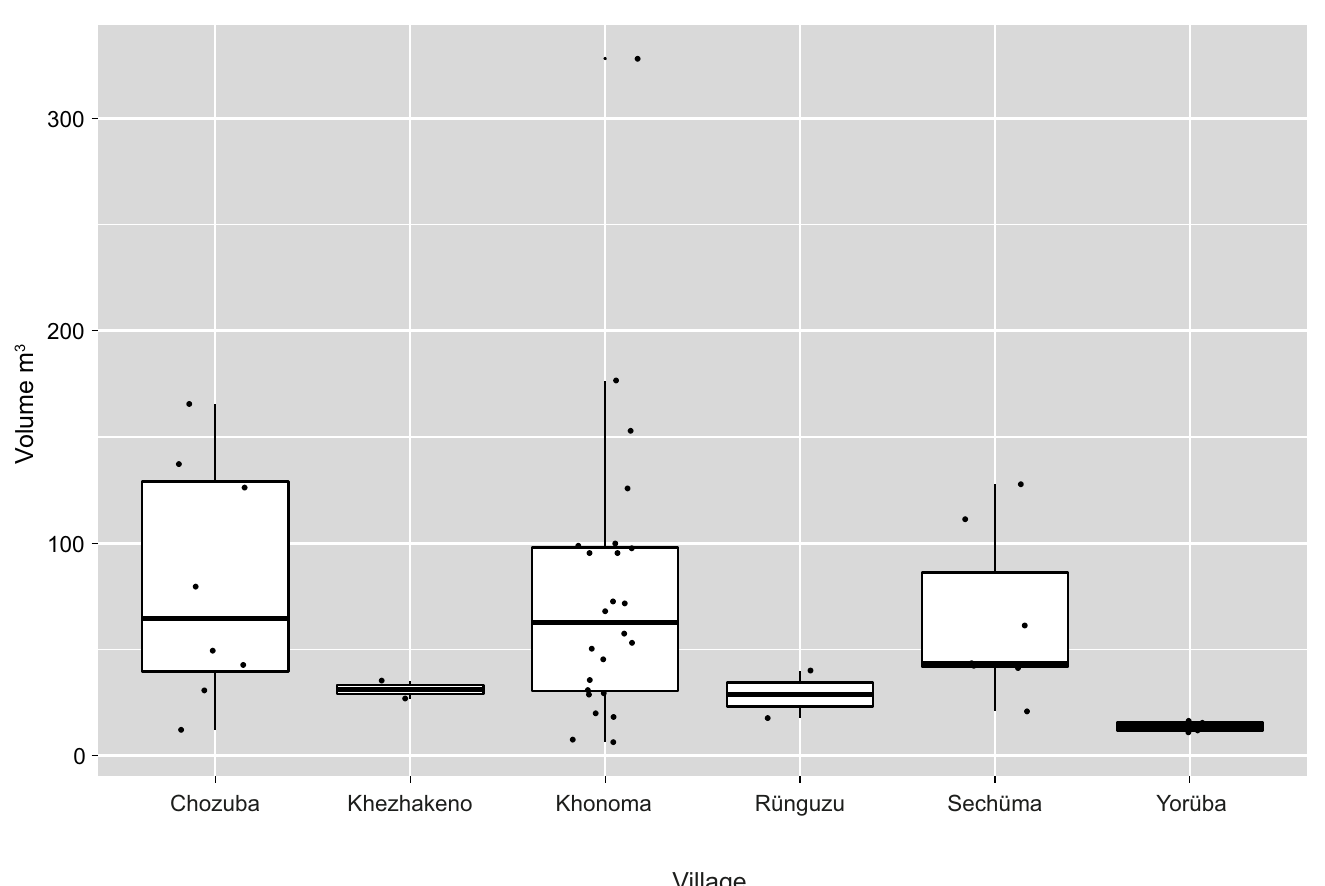
Fig 18. The size distribution (m 3 ) of sitting platforms in the different villages visited in 2016. Khonoma and Sechu¨ma are Angami Naga villages; the remainder are Chakhesang Naga villages (Graphic: M. Wunderlich).